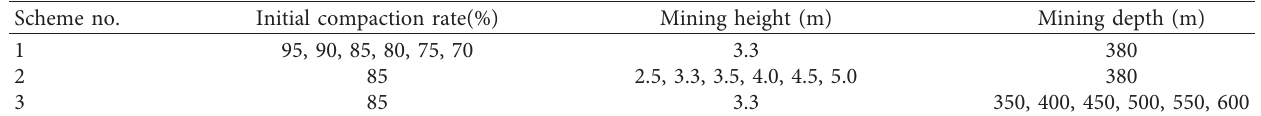
Table 3: Numerical calculation